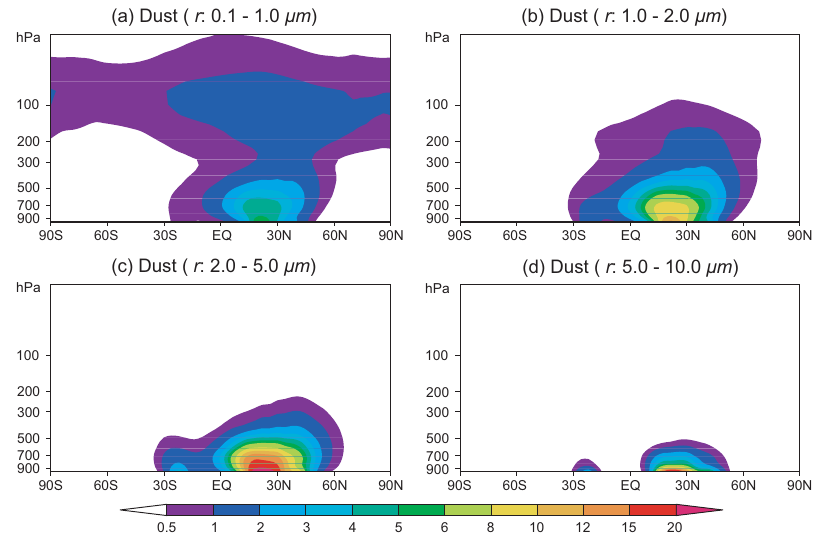
Fig. 3. Annual zonal mean concentrations of dust with radius at (a) 0.1–1.0µm, (b) 1.0–2.0µm, (c) 2.0–5.0µm, and (d) 5.0–10.0µm simulated in the control experiment with fixed SST (FIXSST CTRL). Unit: µg dust per Kg